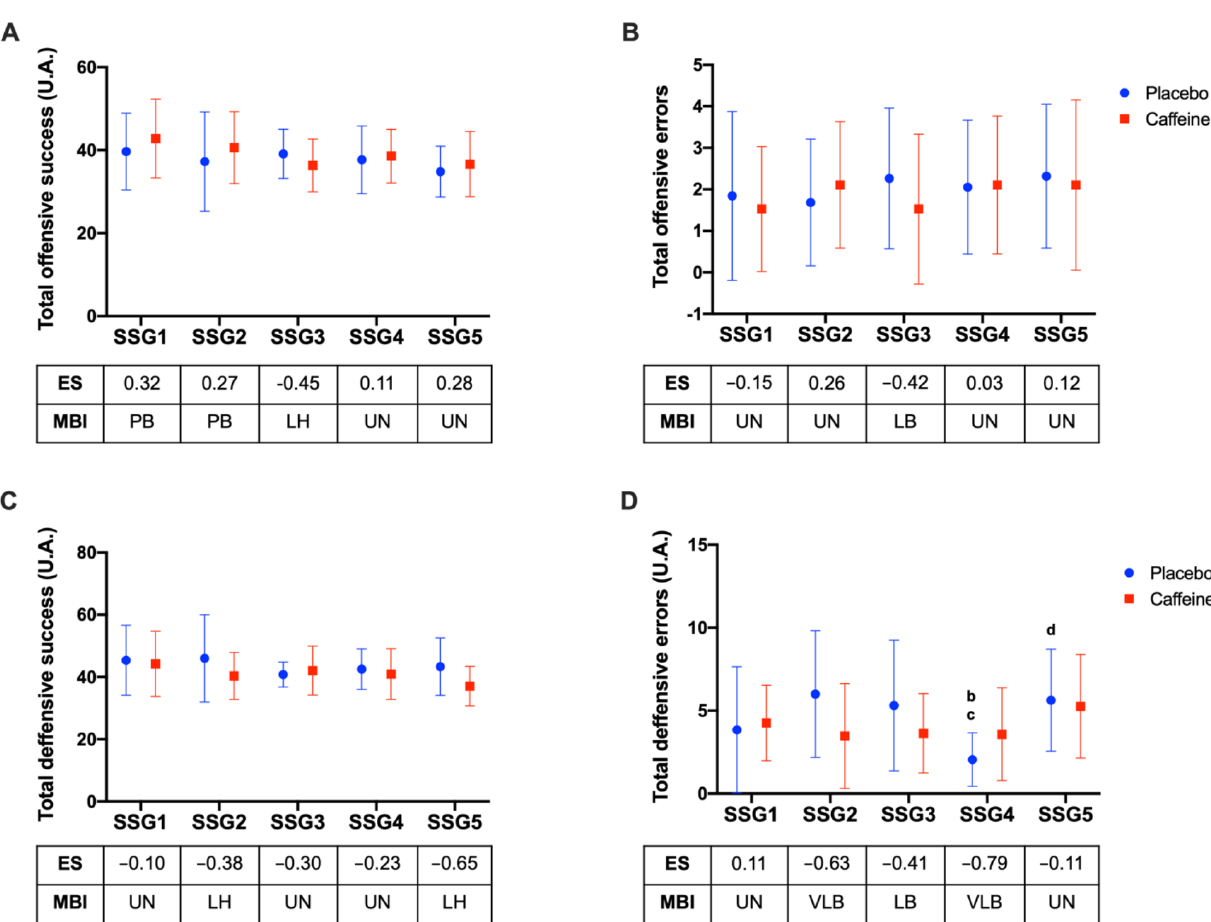
Figure 4. ( A ) Total offensive success; ( B ) total offensive errors; ( C ) total defensive success; ( D ) total defensive errors; (a) ( p < 0.05) differences to rest; (b) to SSG1; (c) to SSG2; (d) to SSG3. AU: